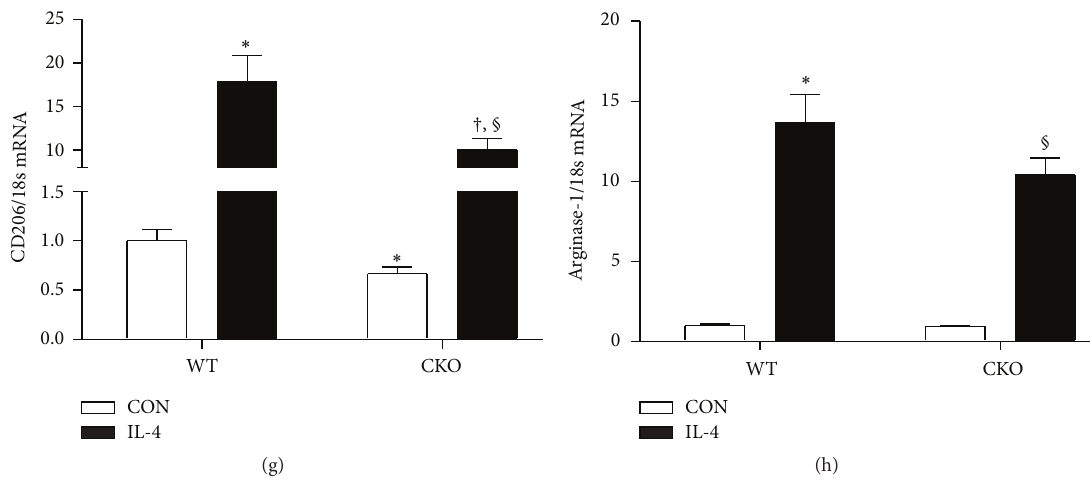
Figure 6: Pharmacological or genetic inhibition of catalase alters macrophage activation in response to LPS or IL-4. RAW264.7 cells were treated with 0, 1, 2, 5, and 10 mM 3-AT and stimulated with 1 ng/mL LPS for 6h or 24 h. (a) JNK phosphorylation at 6h and (b) iNOS levels at 24 h were quantified by western blot (upper panel) and densitometry (lower panel). ∗ 𝑝 < 0.05 versus control; † 𝑝 < 0.05 versus LPS. (c) JNK phosphorylation at 6h and (d) iNOS abundance at 24 h were also measured by western blot (upper panel) and densitometry (lower panel) in WT and CKO bone marrow-derived macrophages treated with 1ng/mL LPS for 6 h or 24 h. ∗ 𝑝 < 0.05 versus unstimulated WT macrophages; † 𝑝 < 0.05 versus unstimulated CKO macrophages; § 𝑝 < 0.05 versus WT macrophages exposed to LPS. All data are mean ± SE of four experiments. (e) CD206 and (f) arginase-1 mRNA levels were measured in RAW264.7 cells treated with 0, 2, and 5 mM 3-AT 1h prior to stimulation with 10 ng/mL IL-4 for 6 h. ∗ 𝑝 < 0.05 versus control; † 𝑝 < 0.05 versus IL-4. (g) CD206 and (h) arginase-1 mRNA levels were also measured in WT and CKO bone marrow-derived macrophages treated with 10ng/mL IL-4 for 6h. ∗ 𝑝 < 0.05 versus unstimulated WT macrophages; † 𝑝 < 0.05 versus unstimulated CKO macrophages; § 𝑝 < 0.05 versus WT macrophages exposed to IL-4. Data are from real-time PCR and are reported as mean ± SE of four